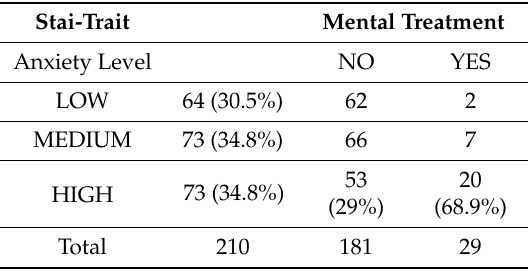
Table 2. The influence of mental treatment history on anxiety levels using STAI-TRAIT subscale. p =